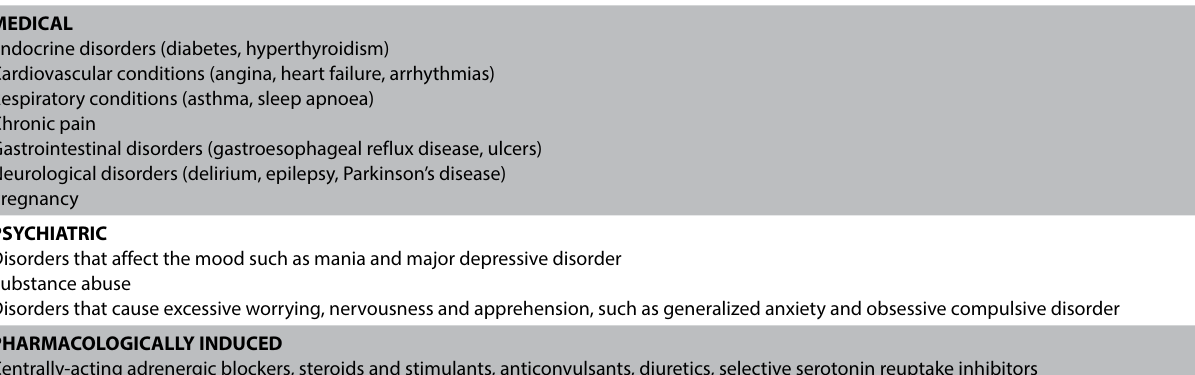
Table 2: Causes of insomnia 5 SITUATIONAL Personal problems, work related stress, financial crisis, conditions that cause extreme tiredness MEDICAL Endocrine disorders (diabetes, hyperthyroidism)